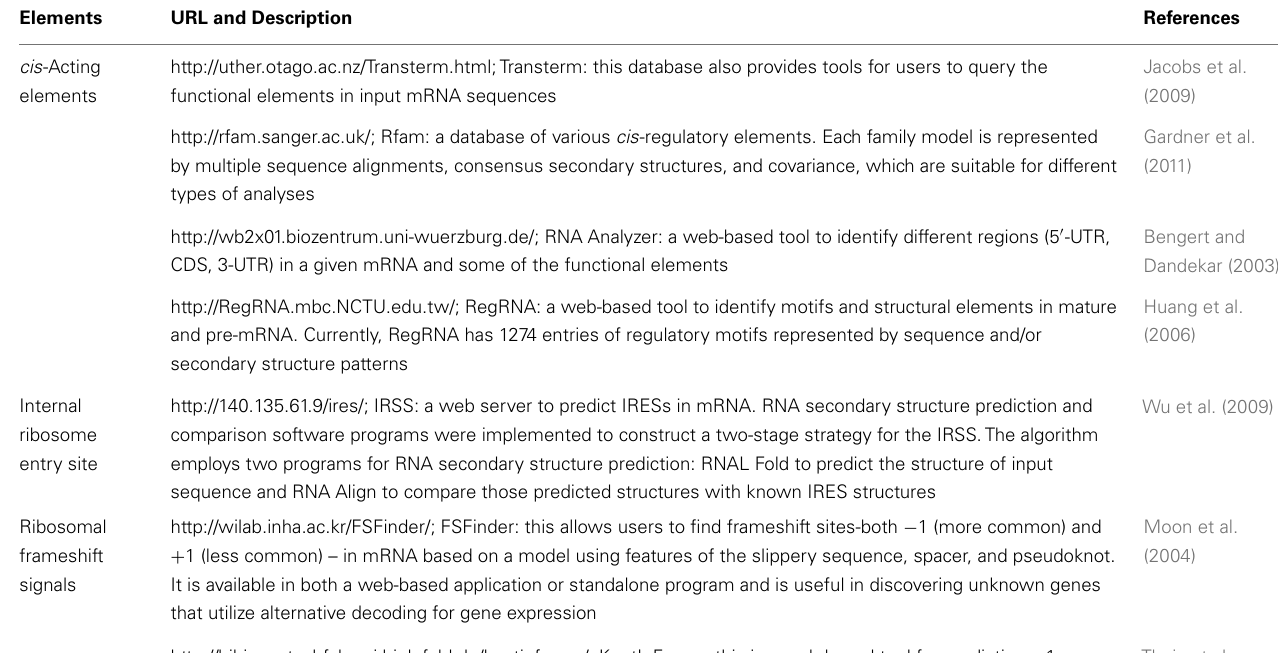
Table 2 |Tools for predicting different functional elements in